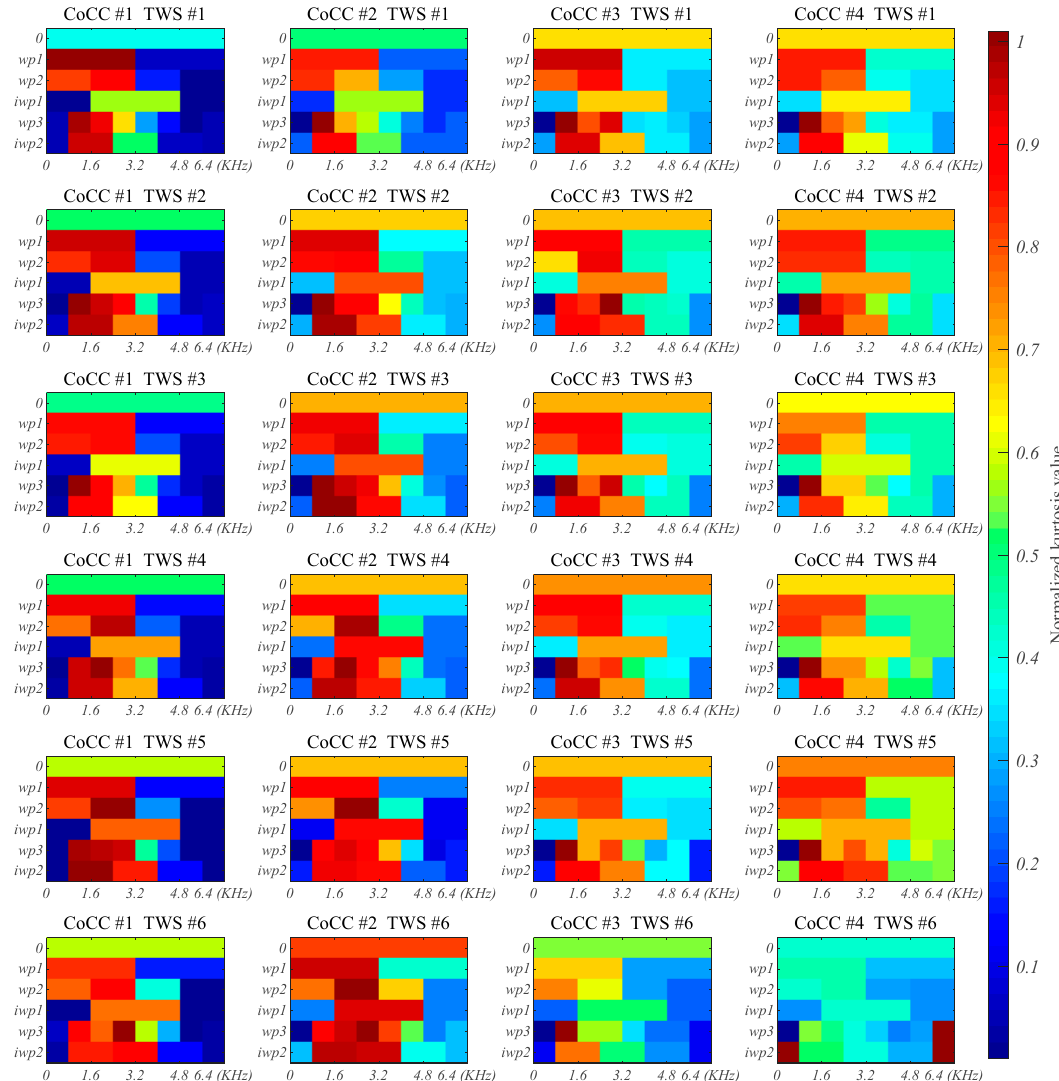
Figure 8. The kurtosis map of the vibration signal after being decomposed via derived wavelet frames (DWFs), where “CoCC” means the combination of cutting conditions and “TWS” means the tool wear state.